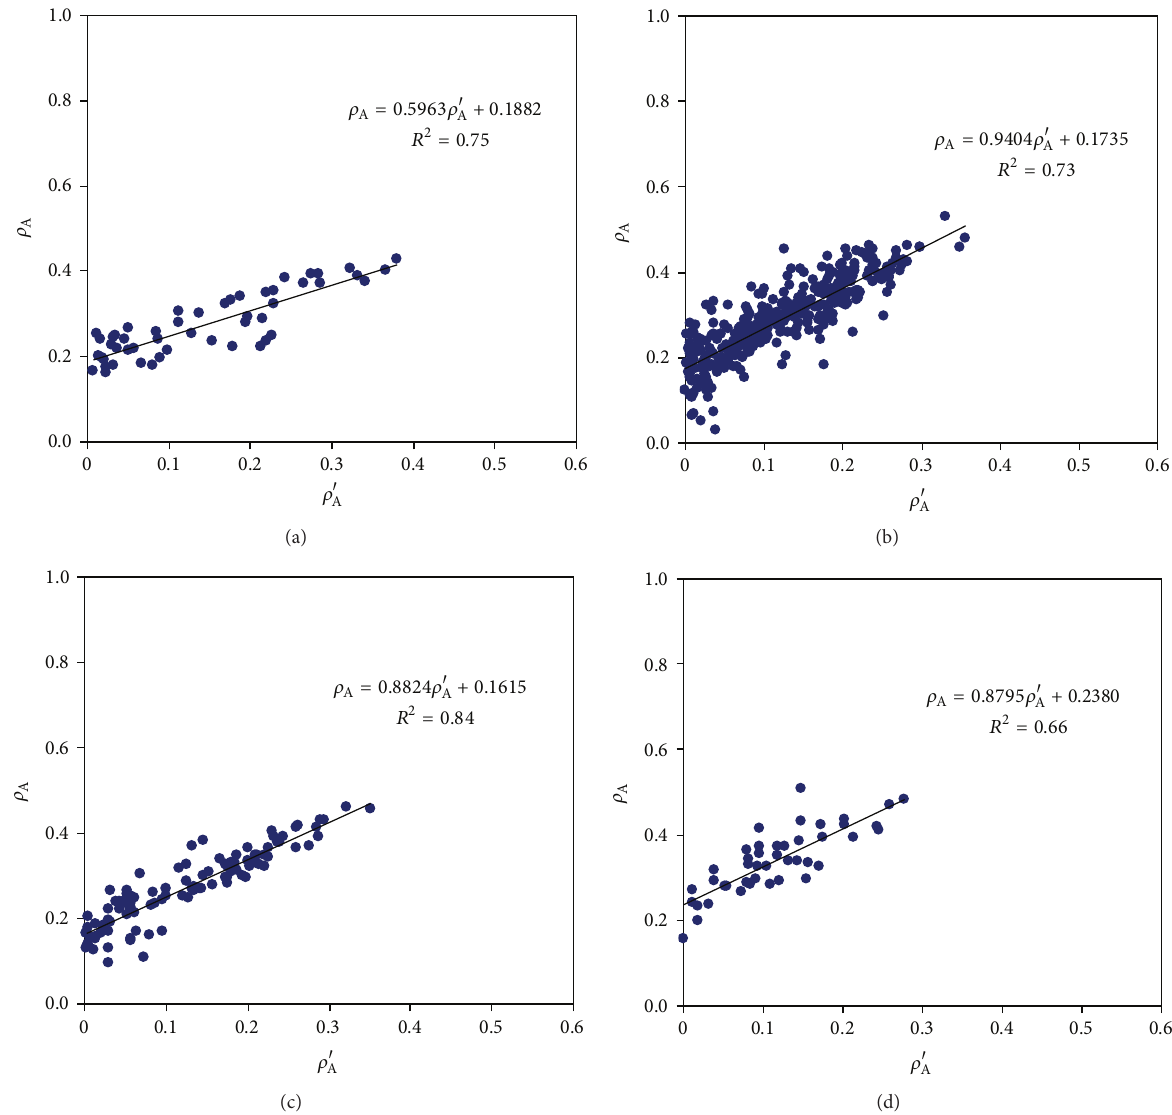
Figure 2: Relation between the broadband atmospheric reflectivity ( 𝜌 GMS5, (c) GOES9 and (d) MTSAT-1R. ( R is the correlation coefficient).